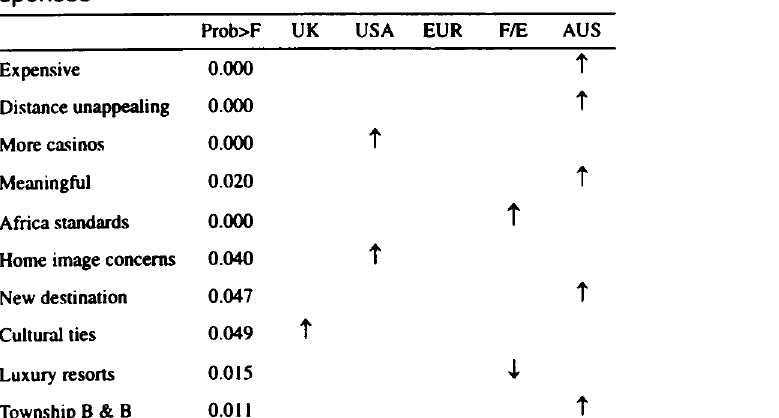
Table 9 ANOVA: geographic variations in statement